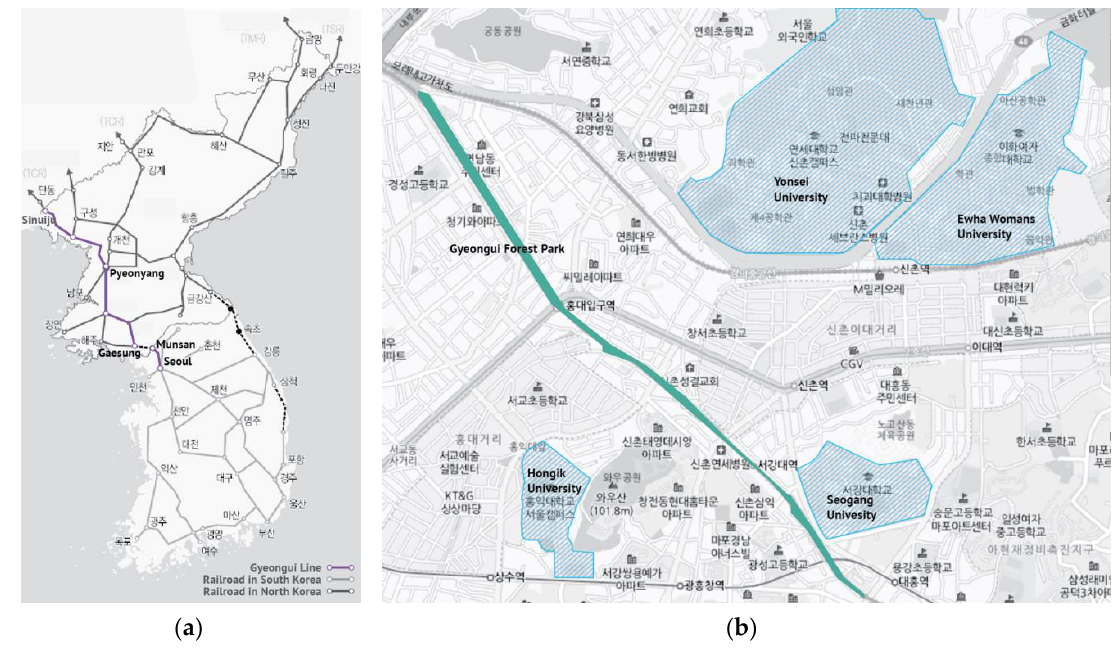
Figure 1. ( a ) Rail road system of Korea; ( b ) Gyeongui Line Forest Park.